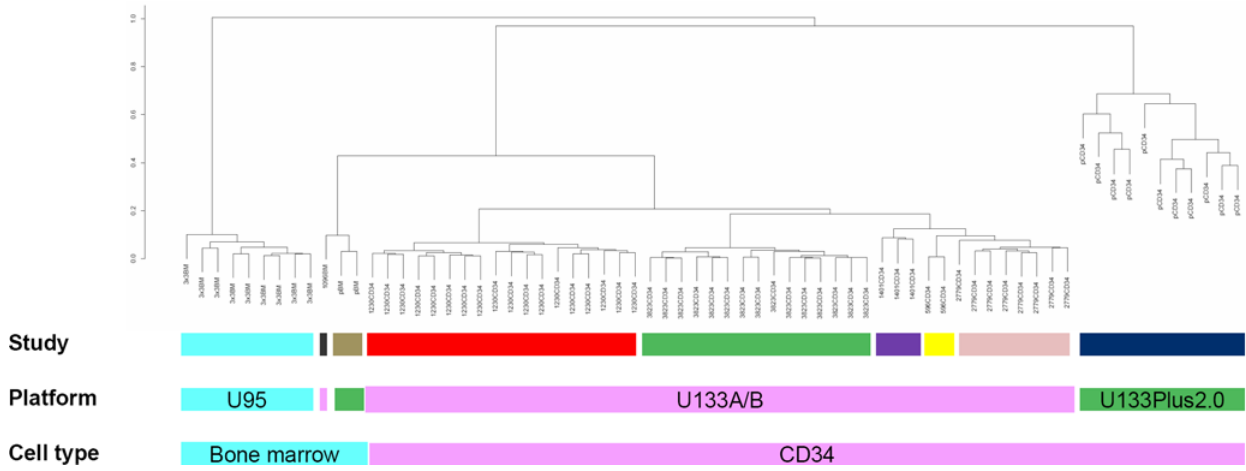
Figure 2. Normal bone marrow HSC clustering. Experimental conditions, microarray platforms and sources of cells influence gene expression patterns of normal bone marrow derived HSCs. Dendrogram of normal bone marrow derived hematopoietic cells based on unsupervised hierarchical clustering, using (1 - Pearson correlation coefficient) as the distance measure. Same color in each horizontal row indicates same group.